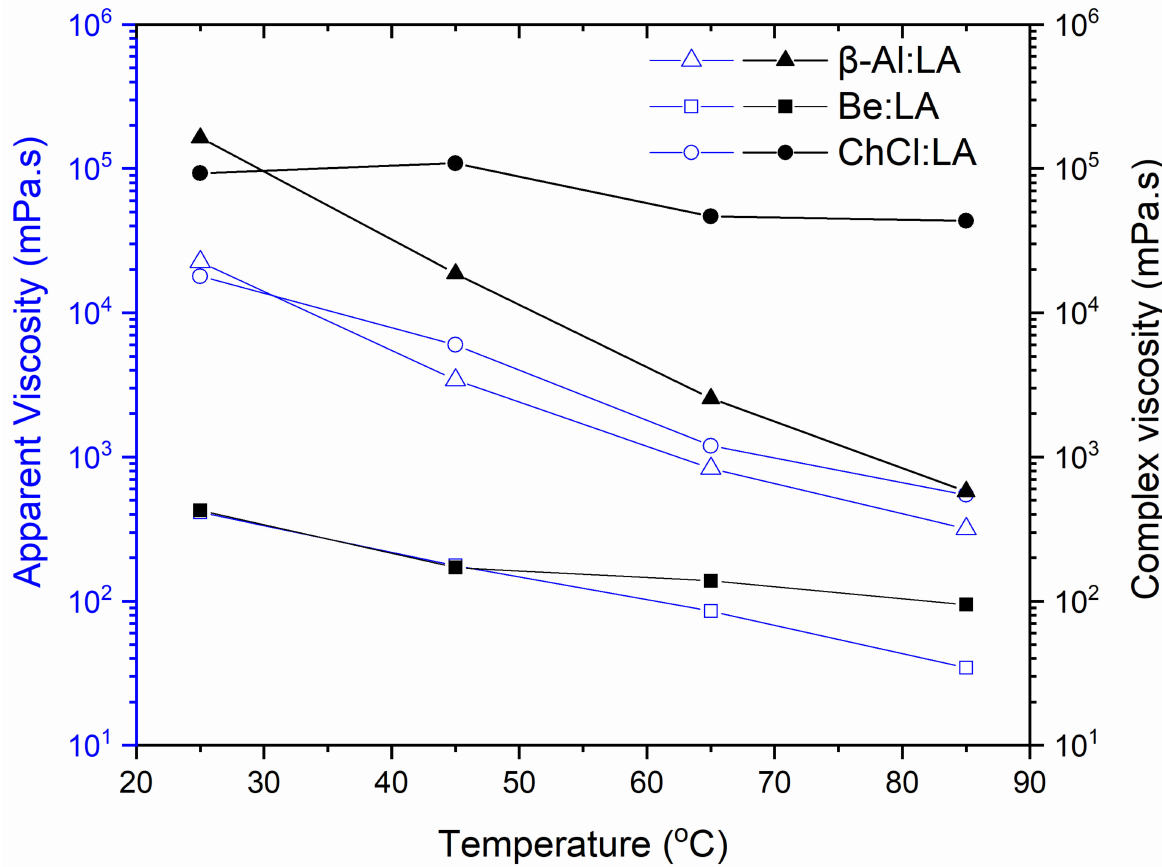
Figure 5. Effect of temperature on complex viscosity and apparent viscosity at an angular frequency of 1 rad · s − 1 and a shear rate of 1 s − 1 at temperatures from 25–85 ◦ C. Figure S3a,b represent the dynamic test finding of the frequency sweep